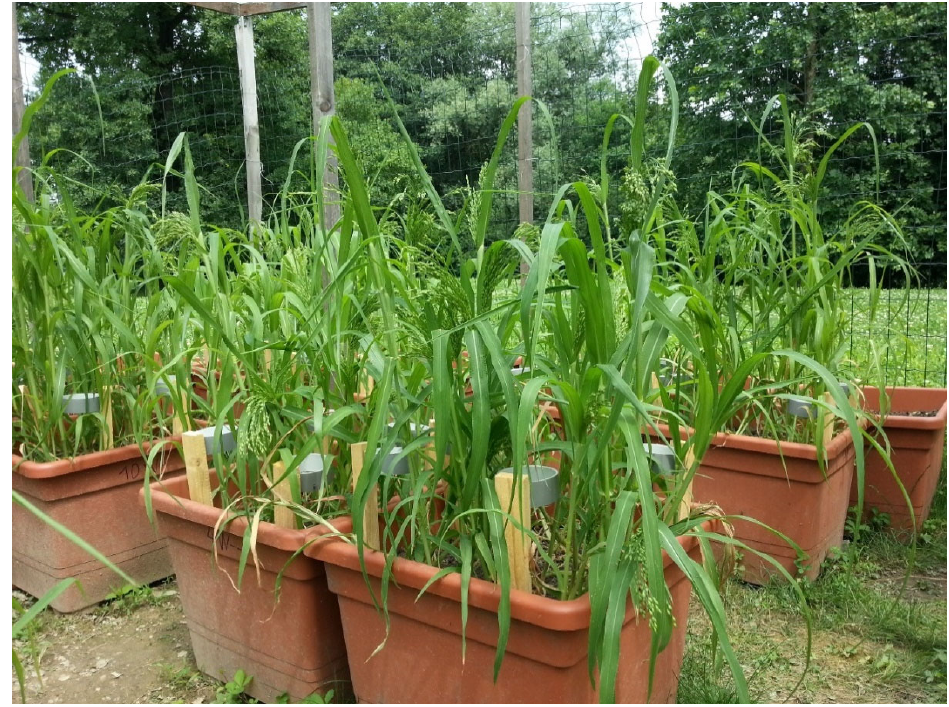
Figure 1. Proso millet experimental plants on day 17 of the experimental period.